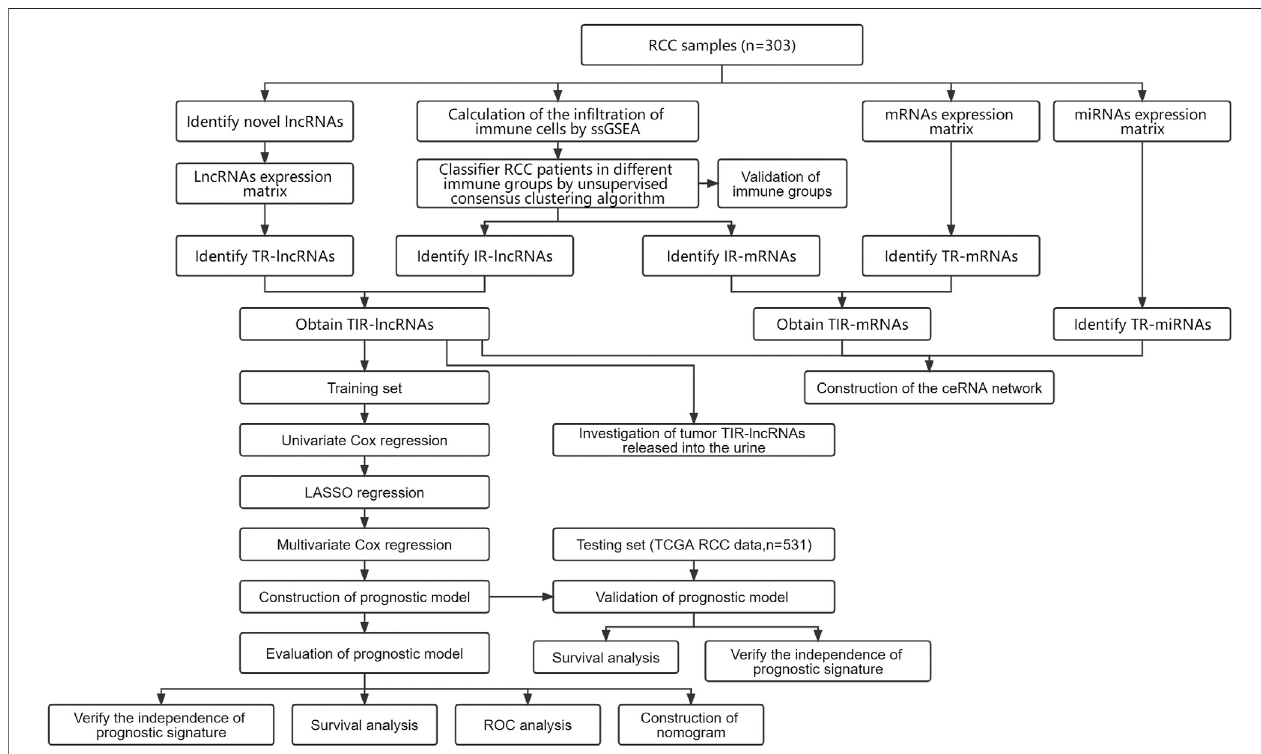
FIGURE 1 | The overall work fl ow and study design showed the process of identifying novel lncRNAs, identifying TIR-lncRNAs, TIR-mRNAs, and TR-miRNAs, constructing ceRNA network, assessing tumor lncRNAs shedding into the urine, constructing and validating the 3-TIR-lncRNAs classi fi ers to predict the prognosis